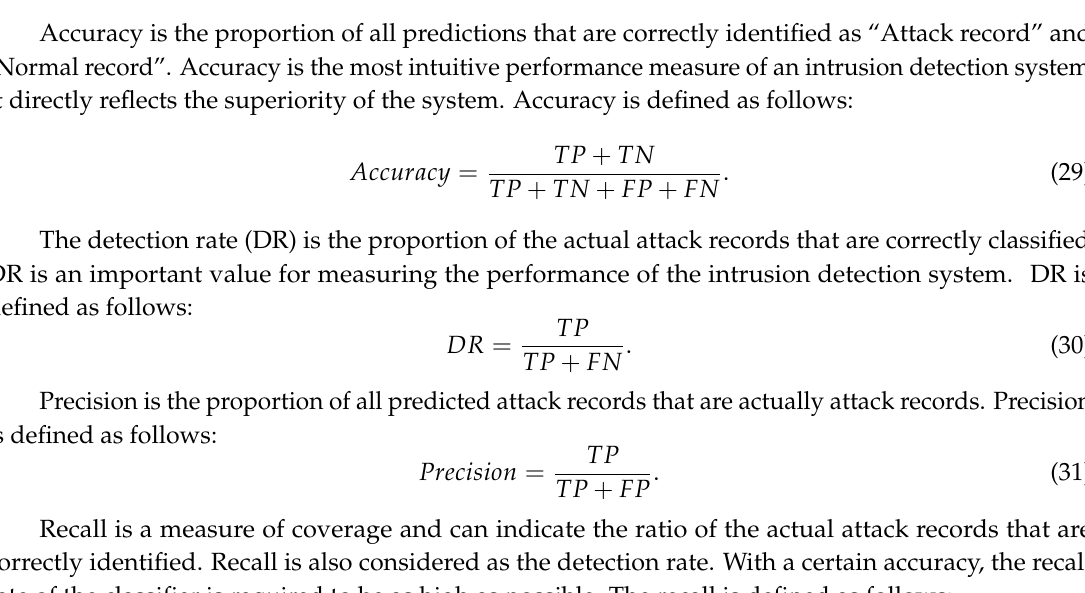
Table 1: True Positive (TP), True Negative (TN), False Positive (FP), and False Negative (FN). TP and